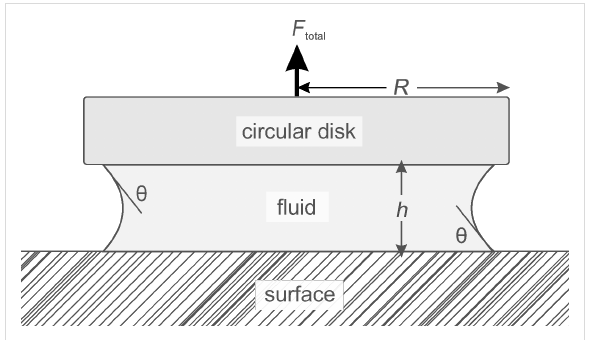
Figure 2: Schematic illustration of a simple fluid-mediated attachment model. The contact of a circular rigid disk (radius R ) and a plane rigid surface is mediated by a thin fluid layer (height h ). The contact angle of the fluid to the surface and the disk θ is assumed to be identical in this